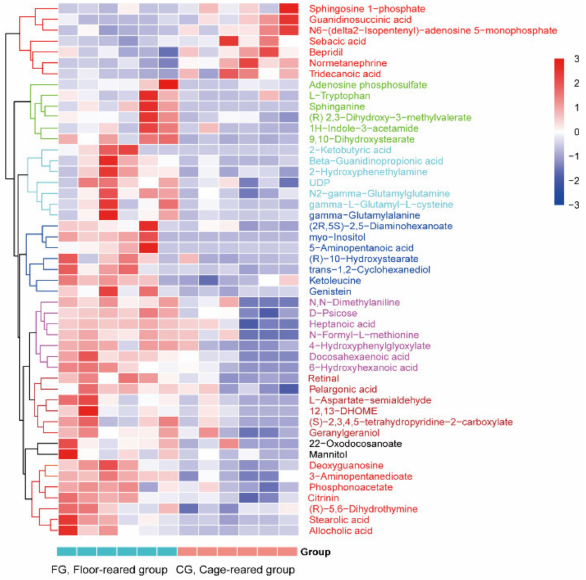
Figure 5. Cluster analysis shows differential metabolites between cage-reared ducks and floor-reared ducks. Each column represents a sample, and each row represents a metabolite. The color in the figure represents the relative content of metabolites in this sample. The closer the distance between two metabolite branches, the closer the expression